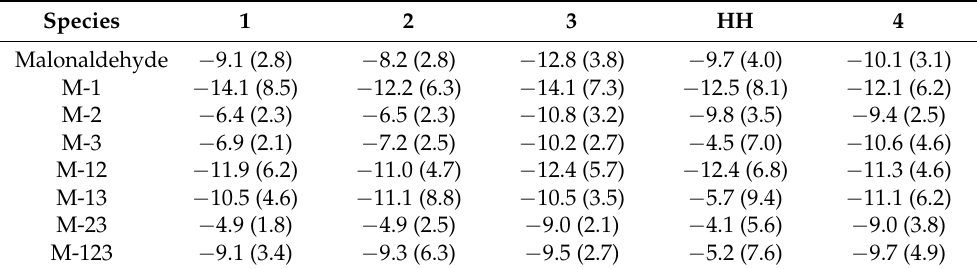
Table 4. Binding energies and deformation energies (in parentheses) of O–H ··· O hydrogen bonds (both in kcal/mol); 1, 2, 3, 4 and HH correspond to configurations presented in Figure 4 that are referred systems to calculate